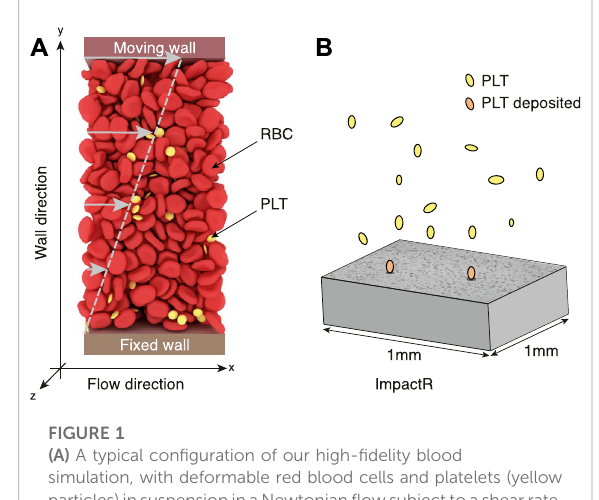
FIGURE 1 (A) A typical con fi guration of our high- fi delity blood simulation, with deformable red blood cells and platelets (yellow particles)insuspensioninaNewtonian fl owsubjecttoashearrate. In this setup, fl uid velocity increases linearly from 0 (at the bottom fi xed wall) to V mw (velocity of the top moving wall). The system has periodic boundary conditions along the x and z axis, while the y -direction (or wall direction) is bounded by walls. (B) Illustration of the process taking place in the Impact-R platelets analyzer.Undertheactionofashear fl owandtheirinteractionwith red blood cells, platelets move towards the bottom of the system where they deposit, forming aggregates displayedon the gray slab as dark